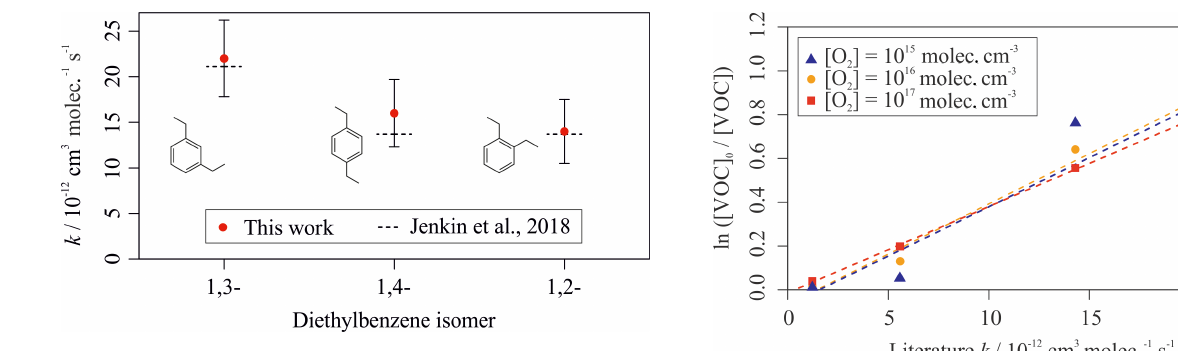
Figure 8. Simulated relative rate plot for four aromatic VOCs when simulating different concentrations of O 2 in the reactor at 300K. From left to right, the data points can be identified as benzene, toluene, p -xylene, and m -xylene. The R 2 values were 0.856, 0.981, and 1.00 for [O 2 ] = 10 15 , 10 16 , and 10 17 molec.cm − 3 respectively. The relationship between depletion factor and k value improved with increasing [O 2 ], suggesting that greater concentrations would be more likely to provide more accurate